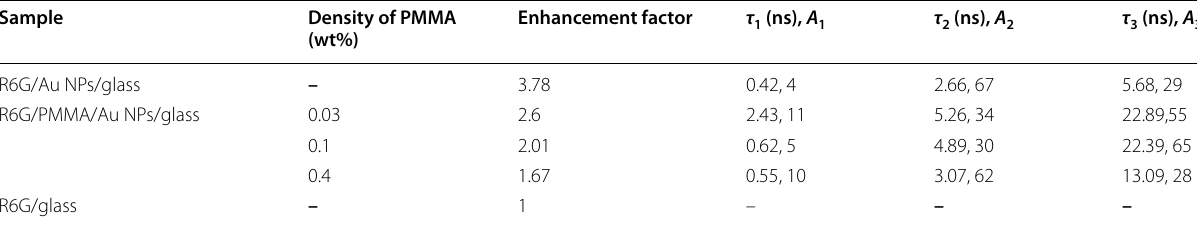
Table 1 Lifetime and enhancement factor of the R6G/glass, R6G/Au NPs/glass and R6G/PMMA/Au NPs/glass samples Sample Density of PMMA